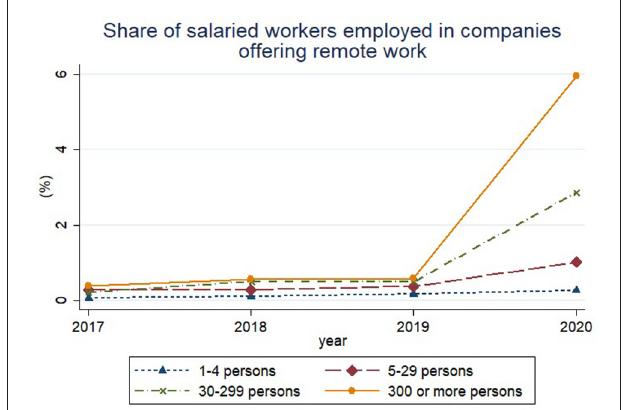
FIGURE 4 | It indicates share of salaried workers employed in companies offering remote work divided by company size. The company size was divided into four groups based on the number of employees. The four groups consist of small businesses with 1–4 employees, small enterprises with 5–29 employees, medium-sized enterprises with 30–299 employees, and large corporations with more than 300